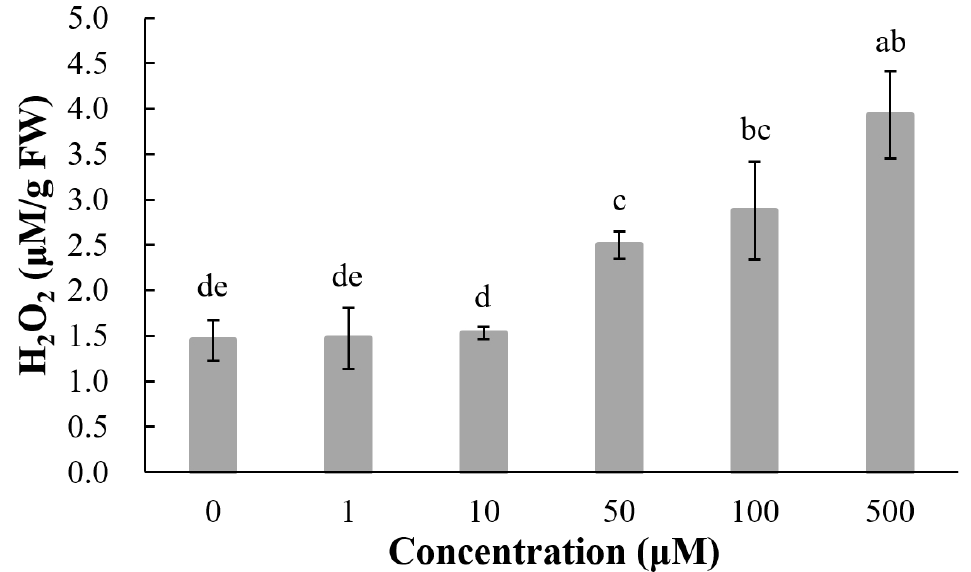
Figure 7. H 2 O 2 contents in roots of lettuce seedlings after treatments with acacetin. The results presented are mean of three replicates ± SE, different letters denote significant differences at p < 0.05 according to one-way ANOVA with an LSD test.